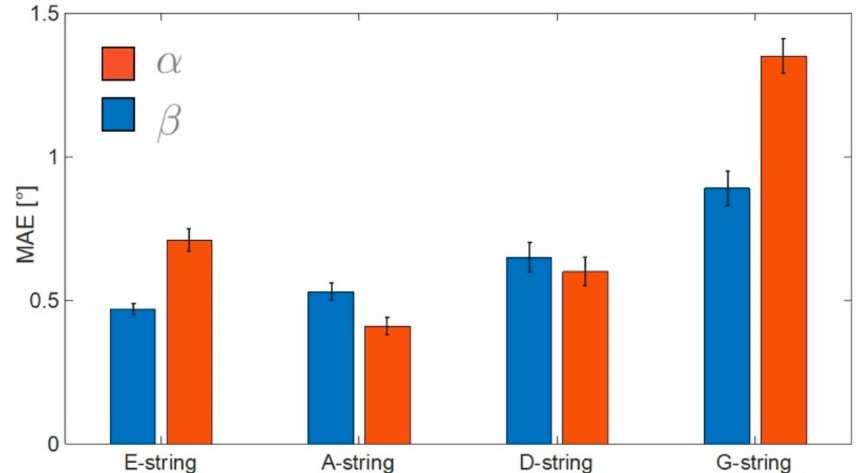
Figure 7. Mean absolute error (MAE) computed on each string for both α and β angles. Bars represent the standard